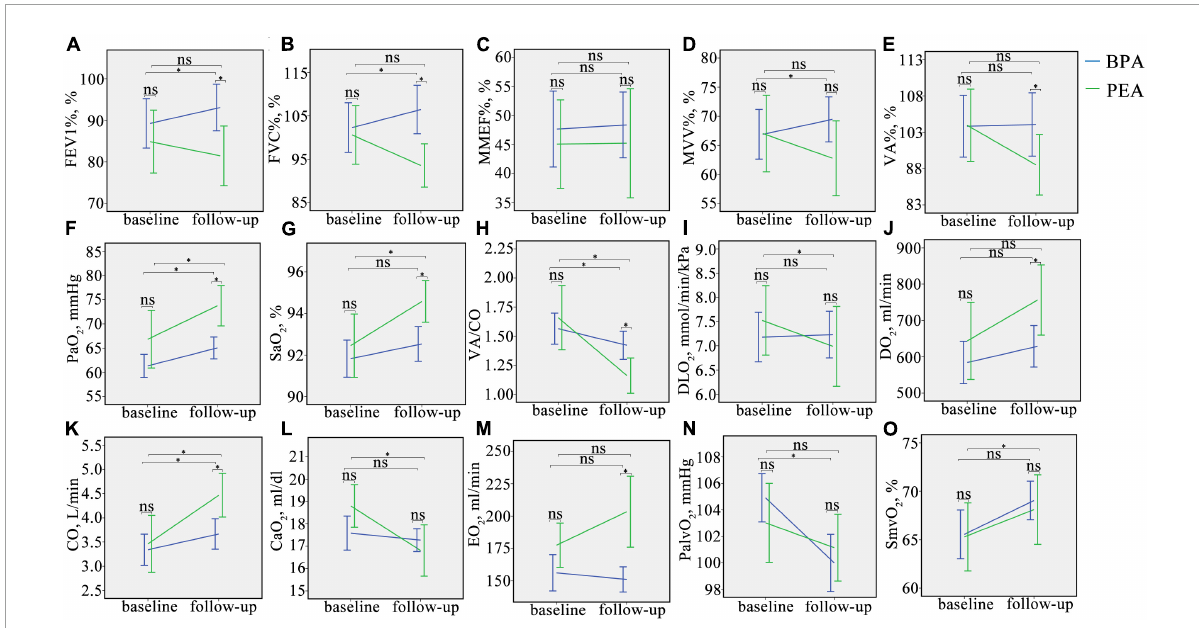
FIGURE2 Changes in oxygen pathway parameters in CTEPH patients before and after intervention. (A–O) , Change in FEV1%, FVC%, MMEF%, MVV%, VA%, PaO 2 , SaO 2 , VA/CO, DLO 2 , DO 2 , CO, CaO 2 , EO 2 , PalvO 2 , and SmvO 2 in CTEPH patients before and after the intervention. ns, no significant difference, ∗ P < 0.05. FEV1%, the percentage of predicted forced expiratory volume in the 1 s; FVC%, the percentage of predicted forced vital capacity; MMEF%, the percentage of predicted maximum mid-expiratory flow; MVV%, the percentage of predicted maximum voluntary ventilation; VA%, the percentage of predicted alveolar ventilation; PaO 2 , partial pressure of oxygen in the radial artery; SaO 2 , saturation of oxygen in the radial artery; VA/CO, alveolar ventilation-to-cardiac output ratio; DLO 2 , diffusion capacity of the lungs for oxygen; DO 2 , oxygen delivery; CO, cardiac output; CaO 2 , arterial oxygen content; PalvO 2 , alveolar partial pressure of oxygen; EO 2 , oxygen extraction; SmvO 2 , mixed venous oxygen